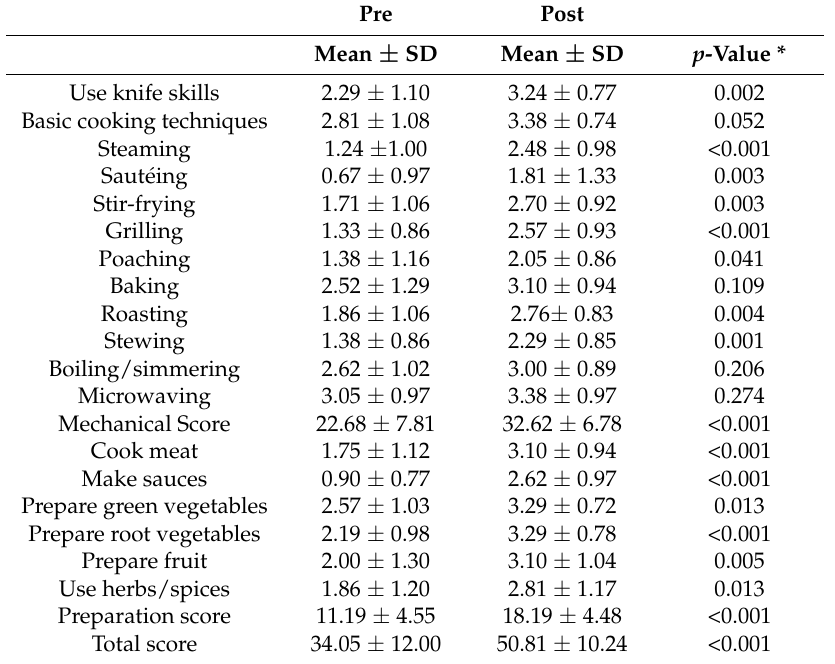
Table 2. Mean (SD) scores for the individual cooking confidence questions and the mechanical and preparation